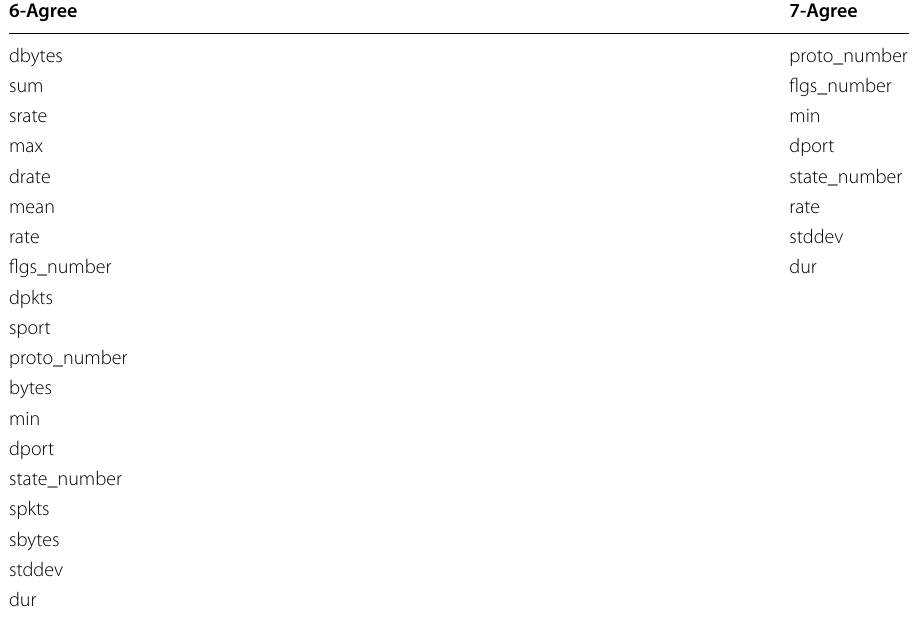
Table 50 Results of the 6-Agree and 7-Agree FSTs 6‑Agree